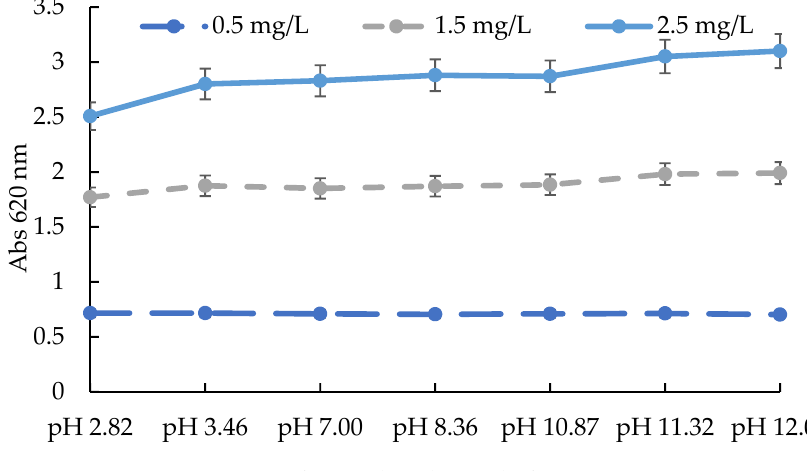
Figure 3. The influences of time, temperature, and pH on the test kit method: ( a ) time; ( b ) temperature; ( c ) pH.